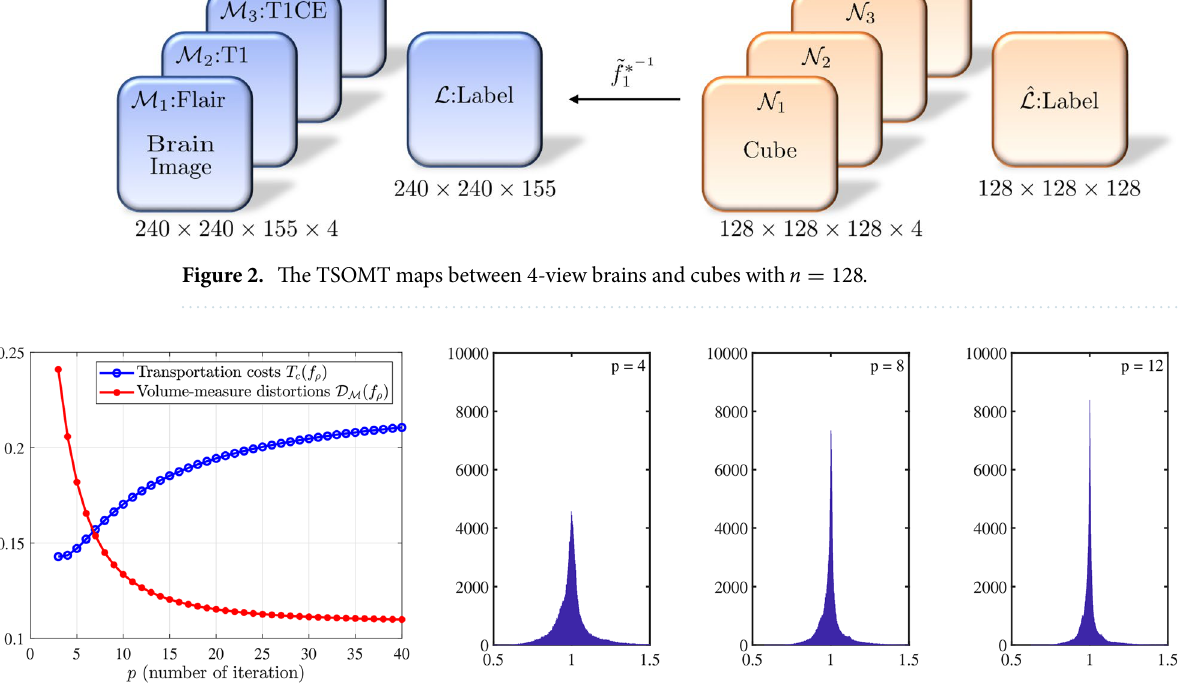
Figure 3. ( a ) The transport costs T c ( f ρ ) and the total mass-measure distortions D M ( f ρ ) vs. the number of partitions p of the homotopy method. ( b ) Histogram of the local mass-measure stretch ratio R M ( f ρ , v ) when 4, 8 and 12 for no. 021. p =